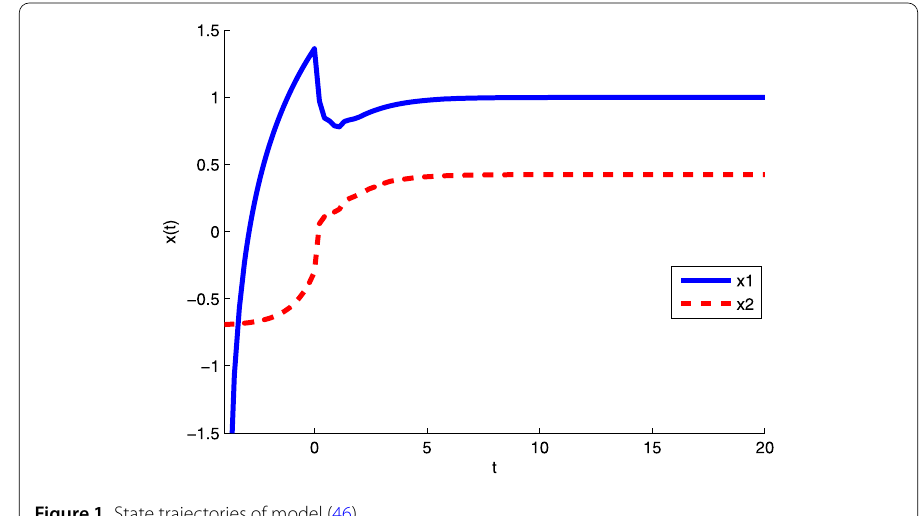
Figure 1 State trajectories of model